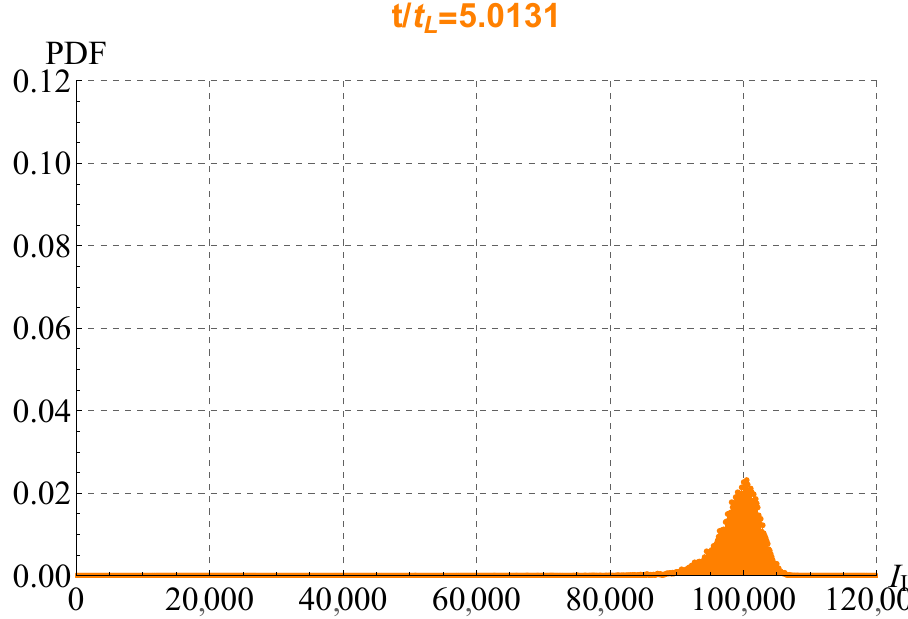
Figure 12. Probability density function (PDF), solution of Equation (36) for Italy, first wave of infection by SARS-CoV-2. Screenshoot at time ˆ t = 5.0131.